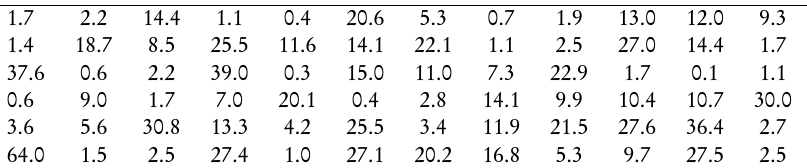
Exceedances of Wheaton river flood